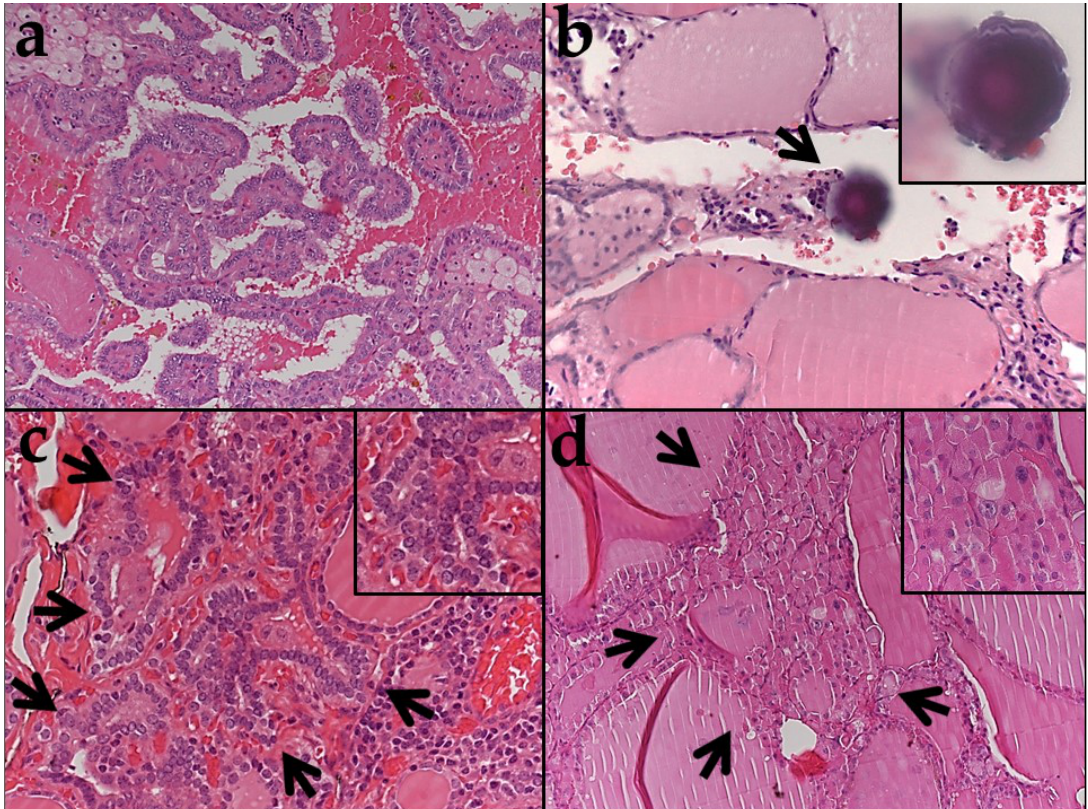
Figure 1. Histologic appearance of the samples analyzed ( a – d ). ( a ) Papillary carcinoma BRAF p.V600E mutated ( × 100). ( b ) Psammoma body (arrow) protruding into a dilated lymphatic space ( × 100); the inset shows the psammoma body at higher magnification and in the plane of focus ( × 400). BRAF p.V600E is identified after sequencing of DNA extracted from the area containing the psammoma body. ( c ) Focus of follicular cell atypia ( × 200) (arrows, inset at higher magnification, × 400). BRAF p.V600M is identified after the sequencing of DNA extracted from the area with follicular cell atypia. ( d ) Focus of follicular cell hyperplasia with oncocytic change (×200) (arrows, inset at higher magnification, ×400). BRAF p. S607P is identified after the sequencing of DNA extracted from the area with follicular cell hyperplasia.